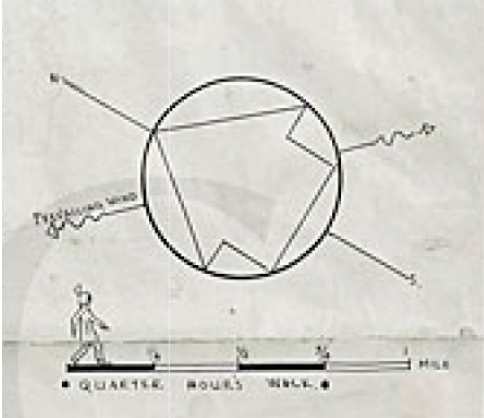
Figure 6. Representation of the quarter-hour on foot on the graphic scale. Extract from the FLC05104. Source: © FLC/ADAGP.